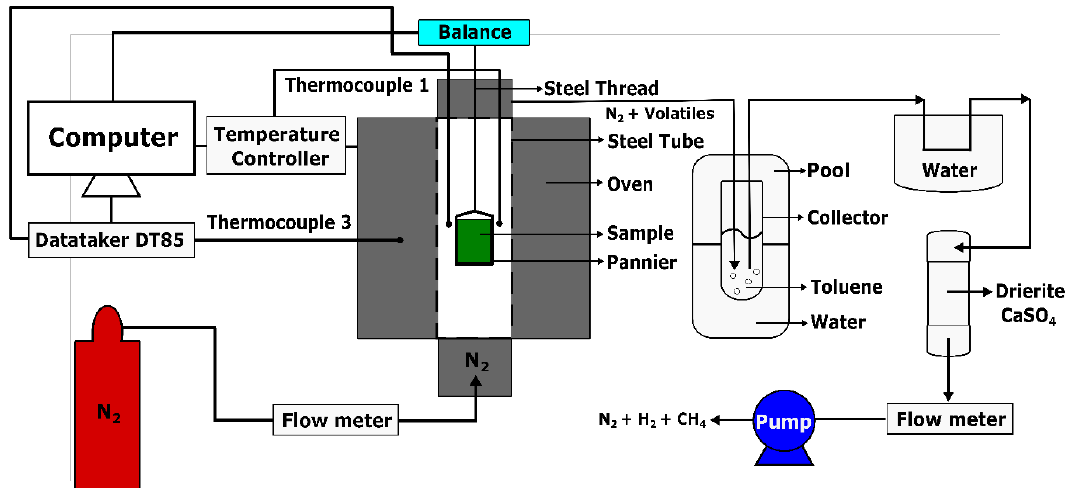
Figure 3. Schematic representation of Thermogravimetric Analysis (TGA) set-up. The initial weight of the anode sample was 150.82 g. During the heating period (Figure 2), the released volatile was mixed up with the nitrogen and passed into a glass collector, containing toluene and then placed in a cold water pool, to dissolve condensable gases in the toluene. To fully eliminate the condensable volatile, it was further condensed in a cold water environment and conducted through the drierite (CaSO 4 ). Finally, the non-condensable volatile with the nitrogen was ventilated by a vacuum pump at a flow rate of 1.5 L/min. The data were measured at a frequency of 0.2 Hz and then integrated using a LabView software and an acquisition center (DataTaker